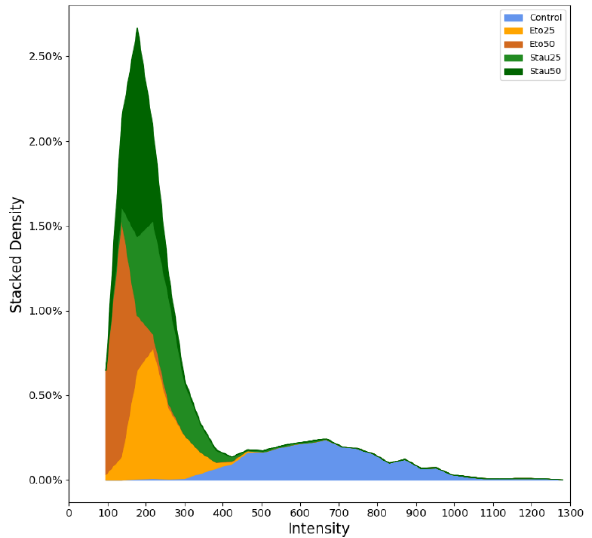
Figure 18. Stacked plot for the semiquantitative analysis showing the distribution of cells based on their fluorescence intensity.